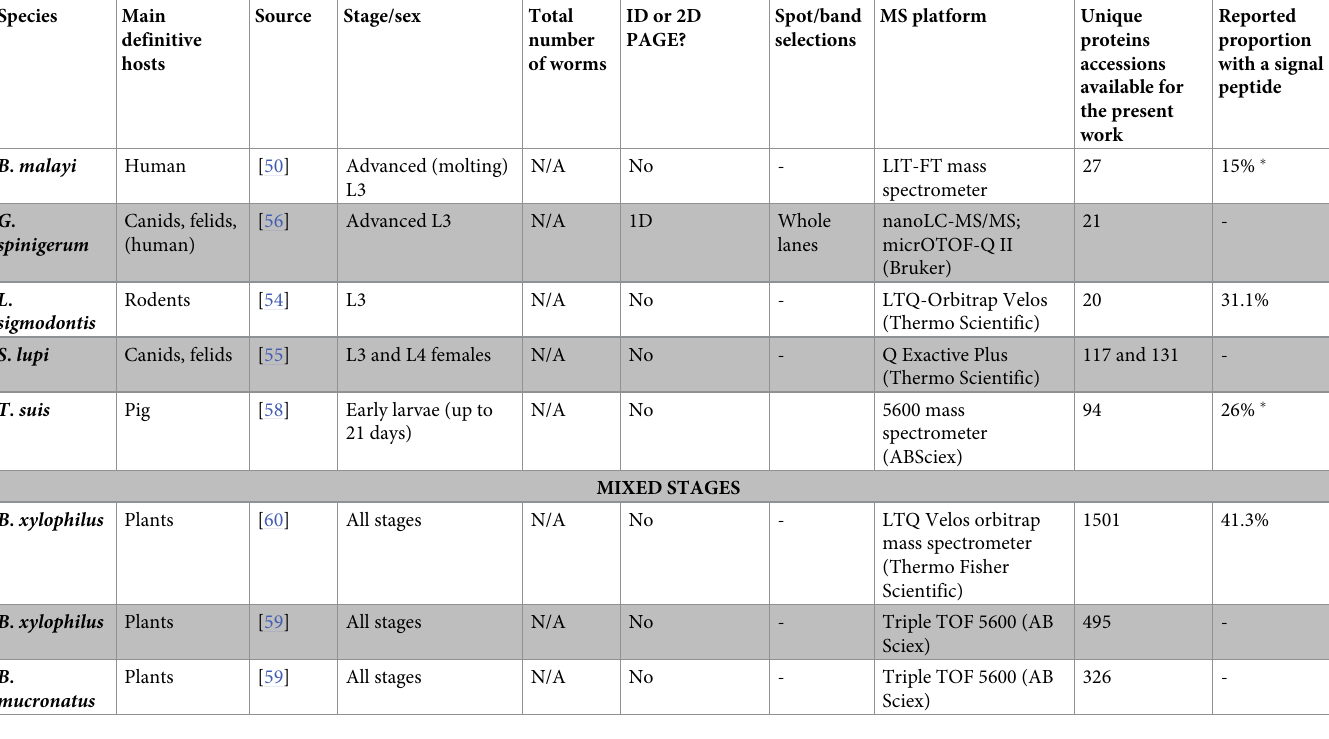
from adult worms and larval stages were analyzed separately, including B . mucronatus and B . xylophilus in both analyses, as these datasets comprised mixed stages. 2.3.2. Orthology inference analysis. Protein sequences from each dataset were aligned against each other (in a blast all-vs-all) using OrthoFinder [64–67] with default parameters. The program finds orthologs and orthogroups and infers gene and species trees. It was fed with adult ESP sequences (fasta), pooling data from different studies for each species: A .